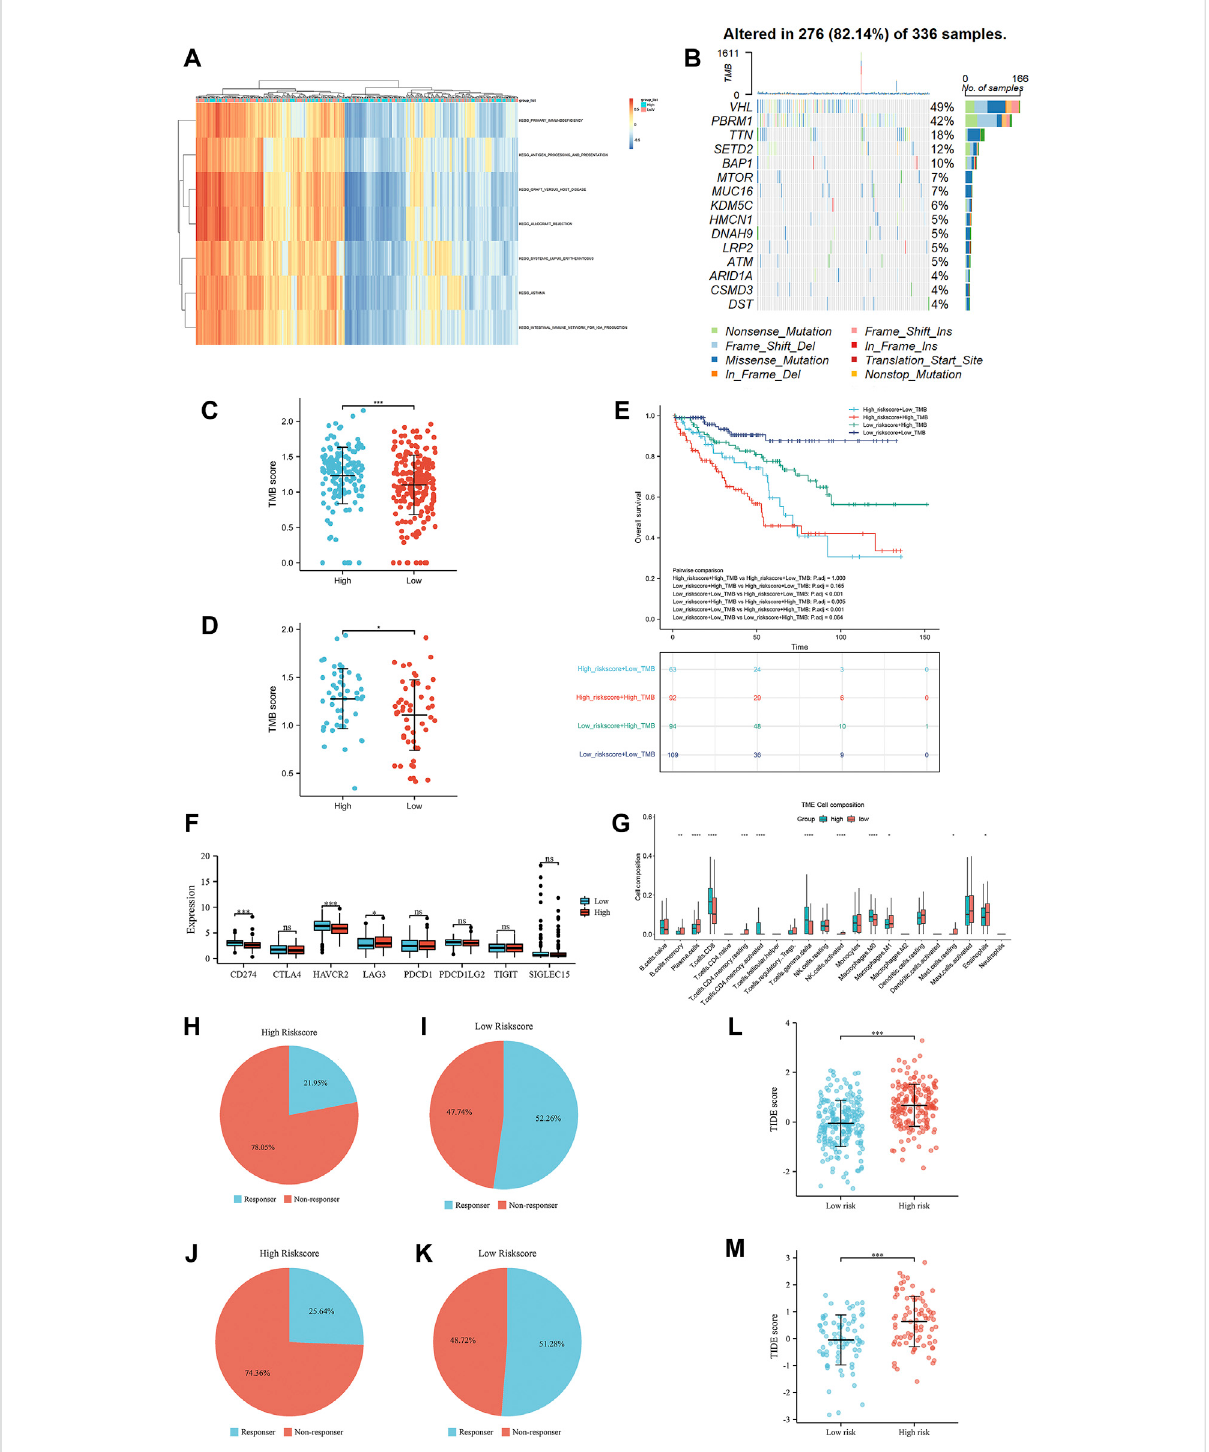
FIGURE 6 The results of gene set variation analysis (A) , the results of tumor mutational burden analysis (B) , the correlation of tumor mutational burden scores and the risk scores in the TCGA training group (C) , the correlation of tumor mutational burden scores and the risk scores in the TCGA test group (D) , the OS of the high-risk group compared with that in the low-risk group in the TCGA training group (E) , the expression of immune checkpoints in the high-risk group compared with that in the low-risk group in the TCGA training group (F) , and the immune cell in fi ltration in the high-risk group compared with that in the low-risk group in the TCGA training group (G) . The TIDE immunotherapy response outcome of high- risk score group (H) and low-risk score group (I) in the TCGA training group, high-risk score group (J) and low-risk score group (K) in the TCGA test group. The TIDE score of the TCGA training group (L) and the TCGA test group (M)